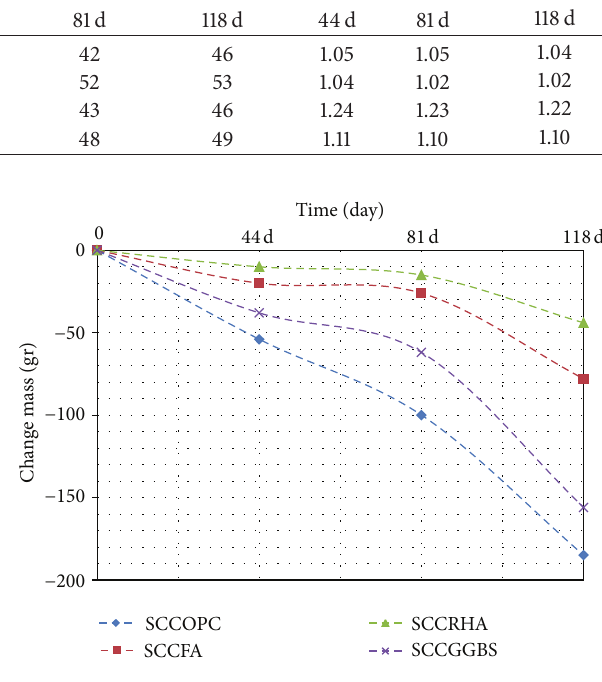
Figure 3: Effect of change in mass between MS and water